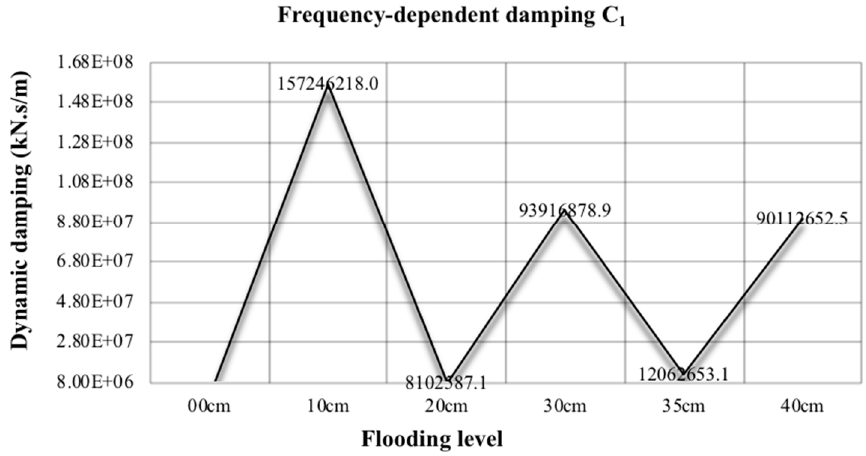
Figure 19. Frequency-dependent damping C 1.